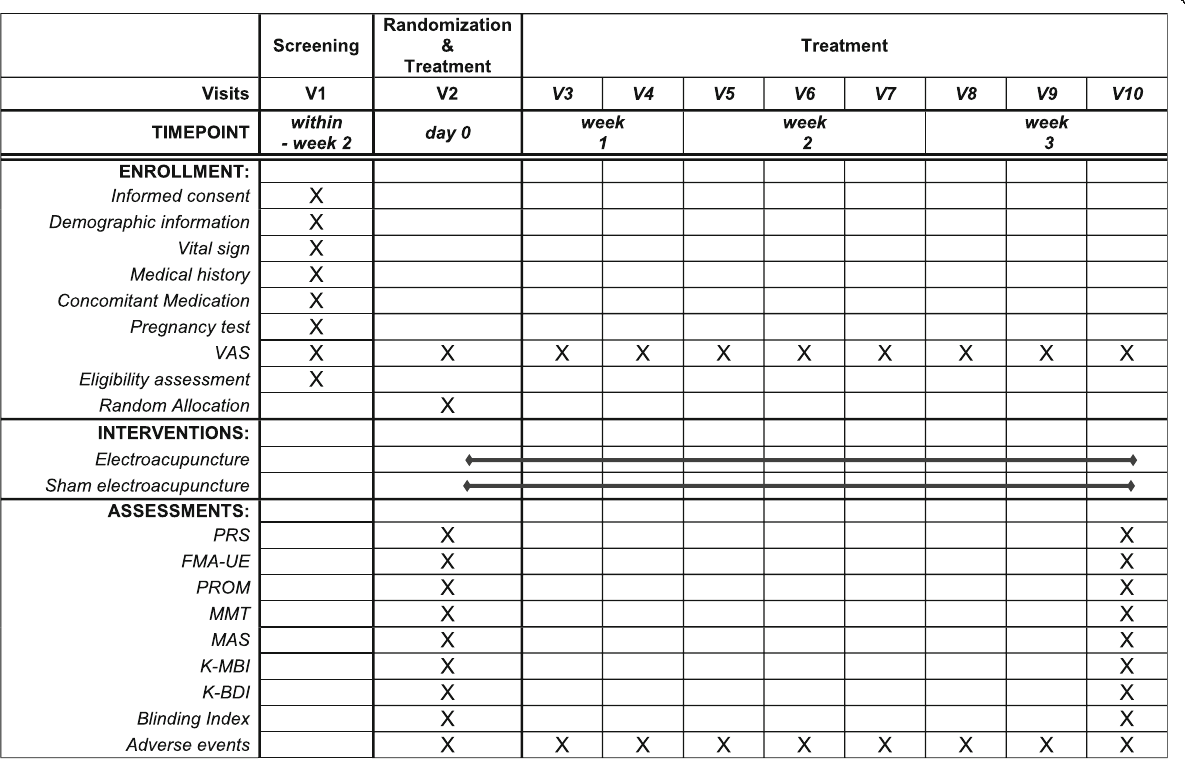
Fig. 2 Study schedule of enrollment, interventions, and assessments. The template is from the SPIRIT 2013 statement [11]. VAS visual analog scale, PRS pain rating scale, FMA-UE Fugl-Meyer assessment upper extremity, PROM passive range of motion, MMT manual muscle test, MAS modified Ashworth scale, K-MBI Korean version of modified Barthel index, K-BDI Korean version of Beck depression